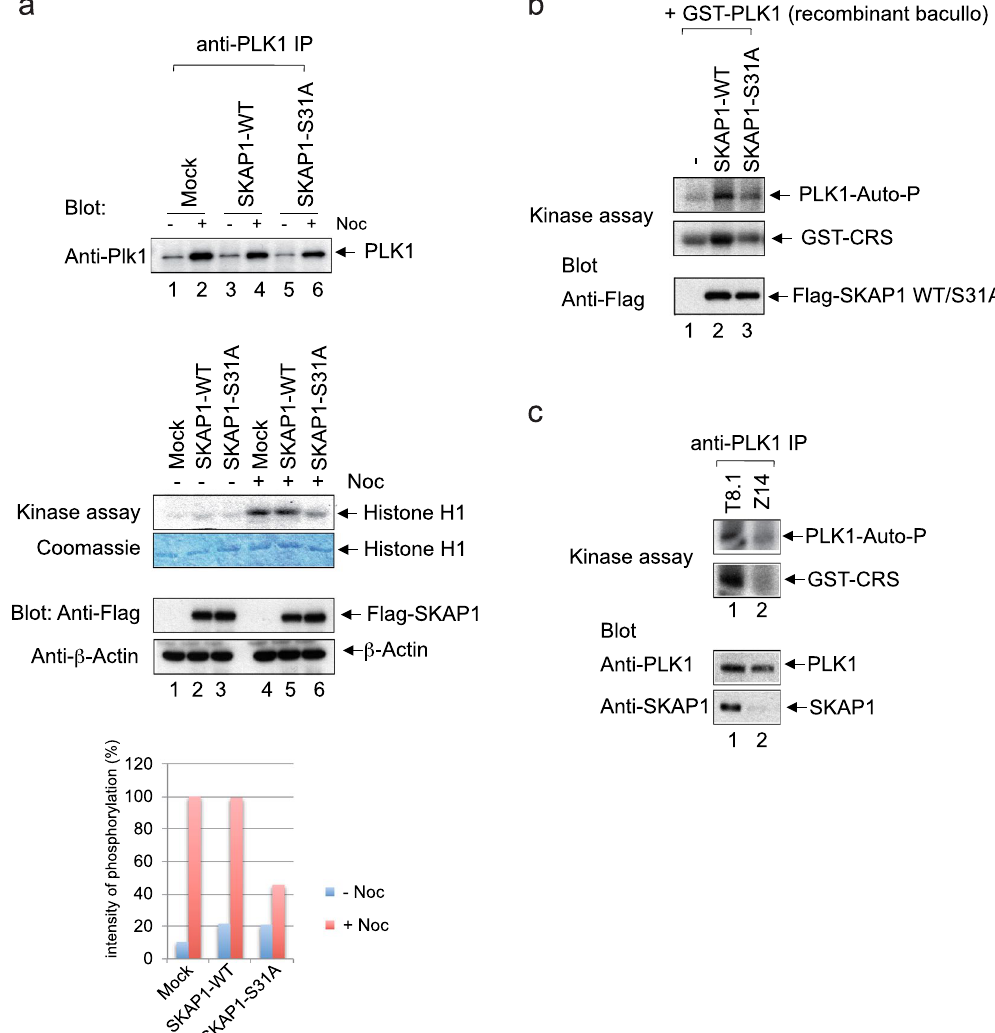
Figure 5. SKAP1 binding regulates PLK1 activity. (Panel a) SKAP1 WT or binding mutant S31A and PLK-1 were co-expressed in Hela cells. Cell growth was arrested in mitosis using 150 nM nocodazole for 16 hours followed by a measure PLK1 activity. Upper panel: Nocodazol induced a similar increase in the expression of PLK1 in cells expressing vector (Mock), WT and S31A SKAP1. Middle panel: Precipitation of PLK1 followed by a measure of in vitro kinase activity of PLK1 using the phosphorylation of histone 1 as a target substrate. Coomassie blue staining show equal loading. PLK1 kinase activity in cells expressing the S31A mutant was reduced (lane 6 vs. 4, 5). Middle panel: a similar level of SKAP1 WT and S31A was expressed in the cells. Lower panel: Histogram showing intensity of histone 1 phosphorylation in %. (Panel b) Recombinant PLK1 kinase was incubated with purified Flag-SKAP1 WT and S31A mutant expressed in 293 T and GST-CRS (cytosolic retention signal of Cyclin B1) as substrate for 30 min, 37 °C in the presence of γ 32 p-ATP. Anti-Flag blot shows equal expression of FLAG-SKAP1 and S31A mutant. PLK1 auto-phosphorylation and GST-CRS phosphorylation was reduced in the presence of S31A mutant. (Panel c) Down-regulation of SKAP1 expression in mouse hybridoma T 8.1 cells (Z14) shows reduced PLK1 kinase activity. PLK1 was immunoprecipitated from detergent lysates of T8.1 cells and used in an in vitro kinase assay with GST-CRS. Anti-PLK1 immunoblot which shows similar levels of immunoprecipitated PLK1. Anti-SKAP1 blot shows down-regulation of